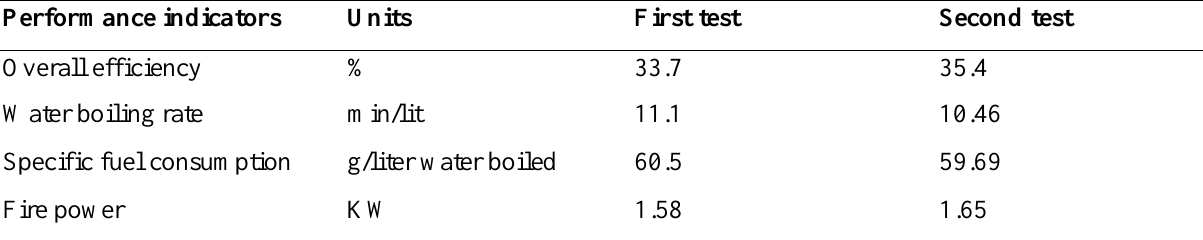
Table 4. Key performance indicators for ICS obtained from WBT